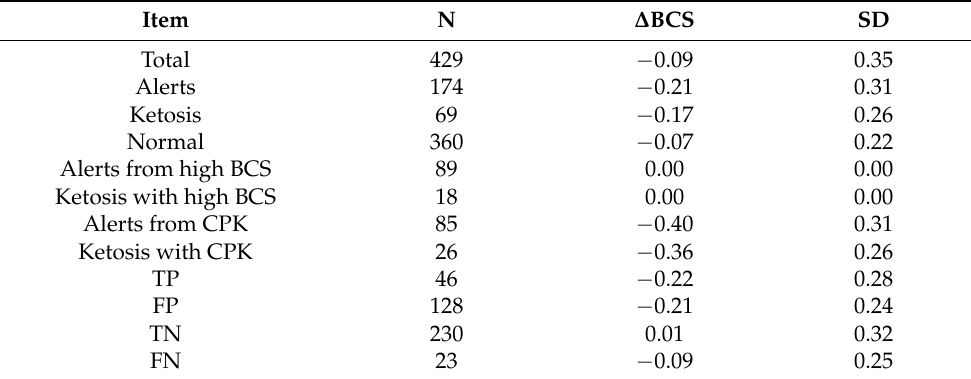
Table 2. Performance of the early warning for the validation period.